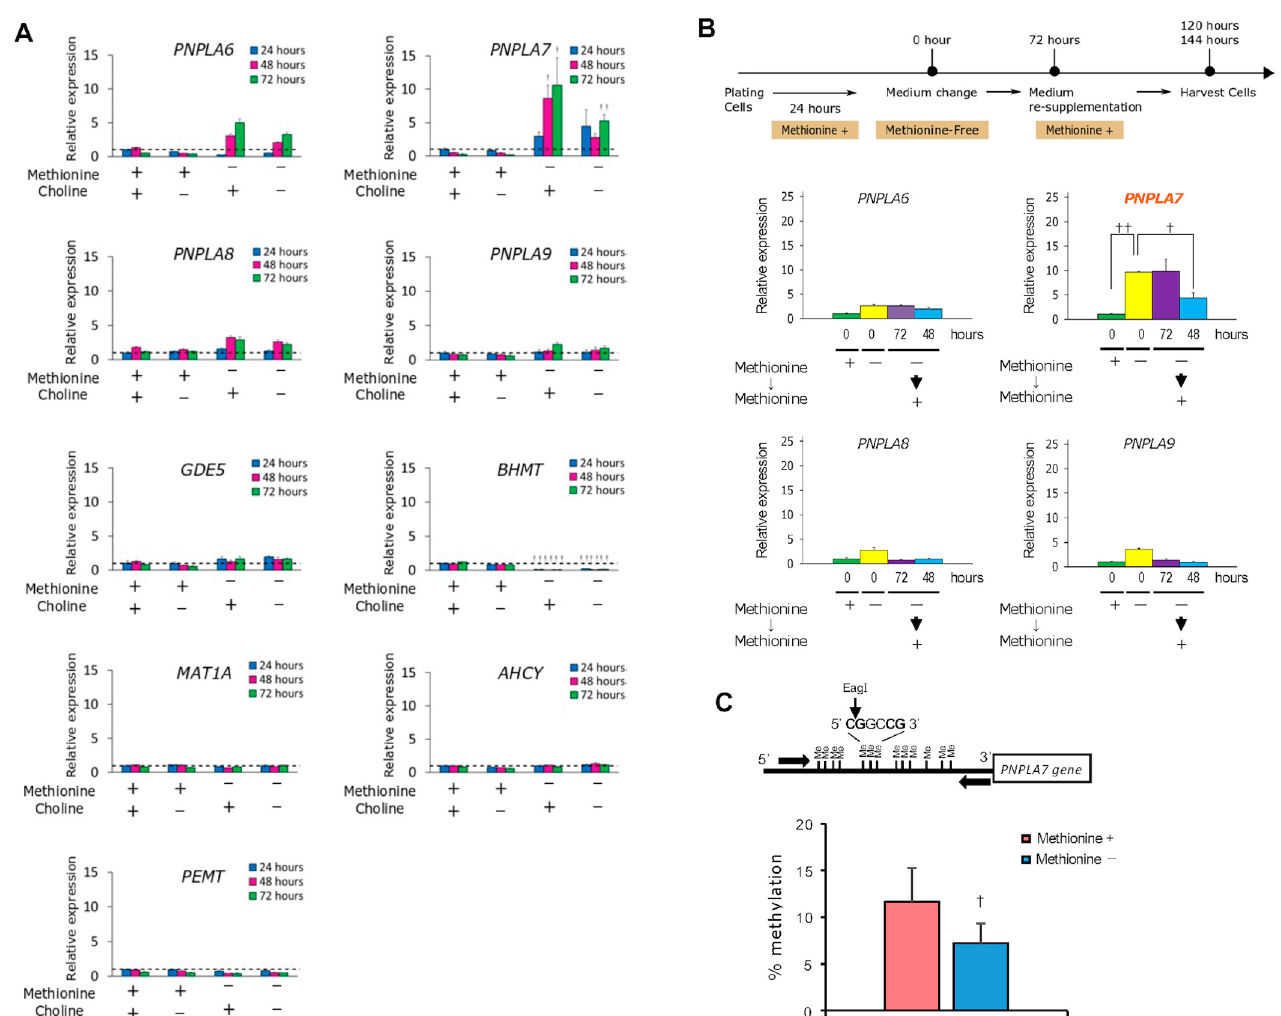
Figure 3. Methionine deprivation upregulates PNPLA7 expression in HepG2 cells by reducing the methylation level in the PNPLA7 promoter. ( A ) Quantitative RT-PCR (qPCR) of PNPLAs and enzymes related to choline/methionine metabolism in cells cultured for the indicated times in the presence (+) or absence ( − ) of choline and/or methionine, with the expression level of each gene under normal culture condition as 1 (dashed lines). Values are mean ± SEM ( n = 6); †, p < 0.05; ††, p < 0.01 versus cells cultured with methionine and choline for 24 h; two-tailed Student’s t -test. ( B ) HepG2 cells were cultured for 72 h in methionine-free medium and then cultured for the indicated times in medium supplemented with methionine ( Top panel ). Graphs show qPCR of PNPLA enzymes upon methionine deprivation followed by its re-supplementation, with the expression level of each gene in cells cultured with methionine for 72 h as 1. Values are mean ± SEM ( n = 3); ††, P < 0.01; ANOVA with Turkey post hoc test. ( C ) Methylation analysis of the PNPLA7 promoter by MSRE-PCR. An image of the methylation status in the PNPLA7 promoter in HepG2 cells and the cleavage site of Eag I, and PCR primers (arrows) used in the MSRE-PCR analysis are shown ( Top panel ). A graph shows frequency of the methylated Eag I-CpG site in the PNPLA7 promoter in HepG2 cells cultured with or without methionine. Values are mean ± SEM ( n = 4); †, p < 0.05; two-tailed Student’s t -test. In the qPCR analysis ( A , B ), total RNA was extracted from the cells using the TRIzol Reagent (Thermo Fischer Scientific, Waltham, MA, USA, #15596018), cDNA was synthesized using random primers and a High-Capacity cDNA Reverse-Transcription Kit (Thermo Fischer Scientific, #4368813), and PCR was carried out using TaqMan Gene Expression Master Mix (Thermo Fischer Scientific, #4369016) and TaqMan Gene Expression Assays (TaqMan probe-primer sets) on a StepOnePlus Real-Time